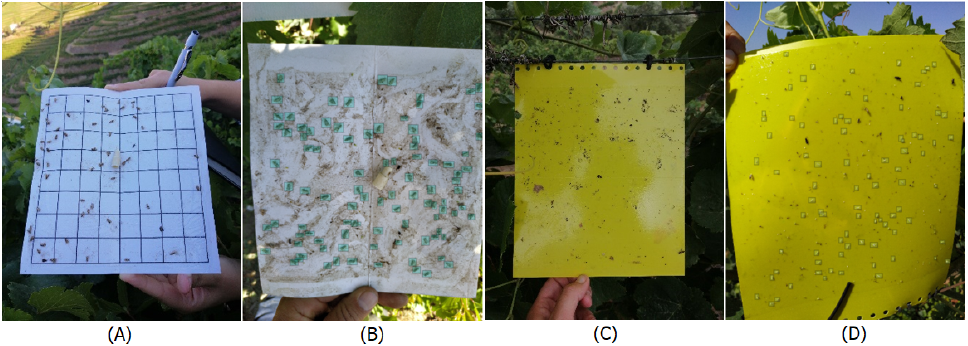
Figure 2. Illustrative images of original delta ( A ) and yellow sticky ( B ) traps comprised in the mobile- acquired image database. Images ( C , D ) illustrate manual annotations of GM and GL, respectively.